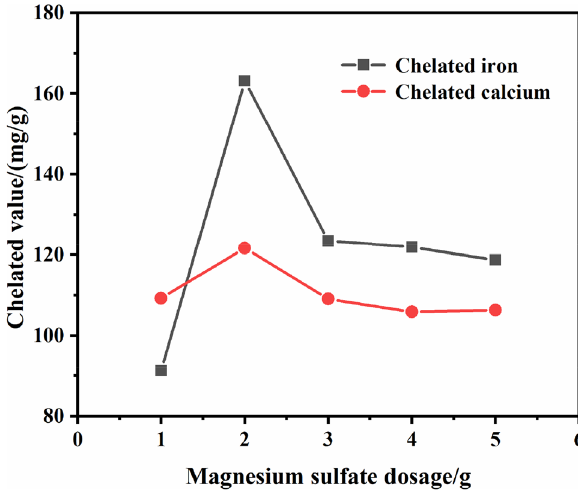
Figure 2. Effect of magnesium sulfate dosage on chelated value.